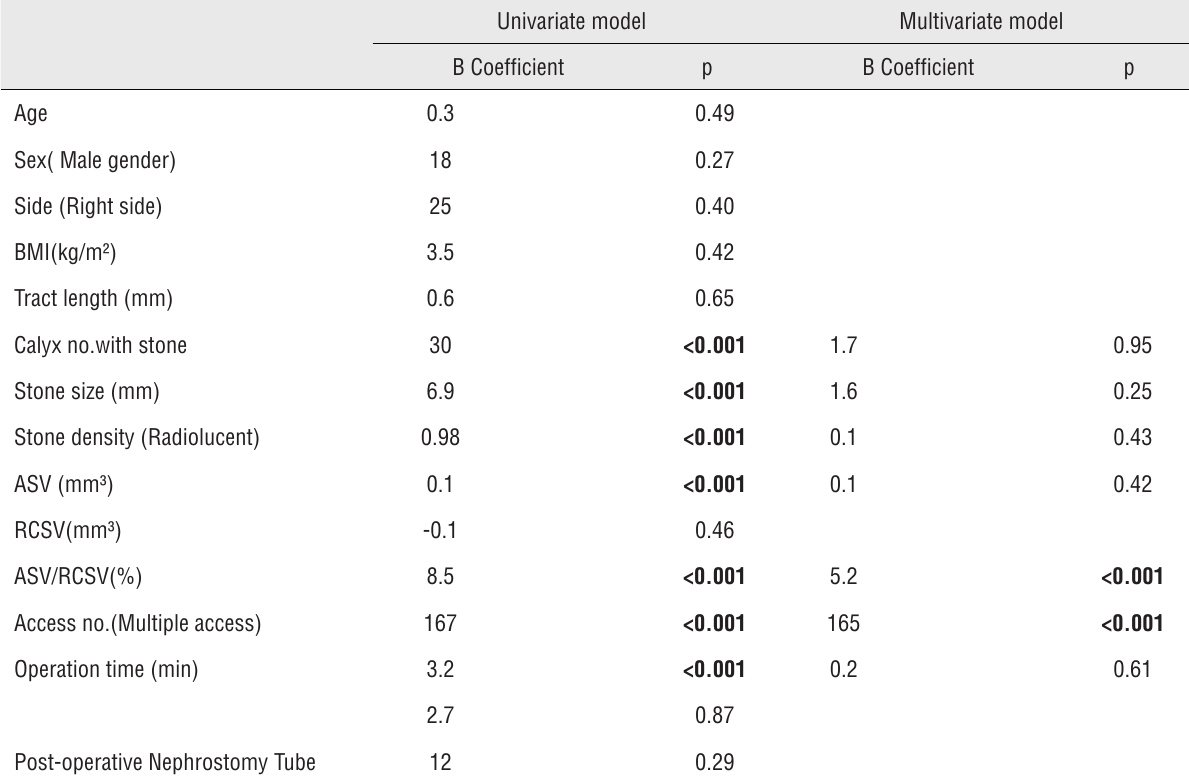
Table 2 - Predictors of fluoroscopy time on linear logistic regression